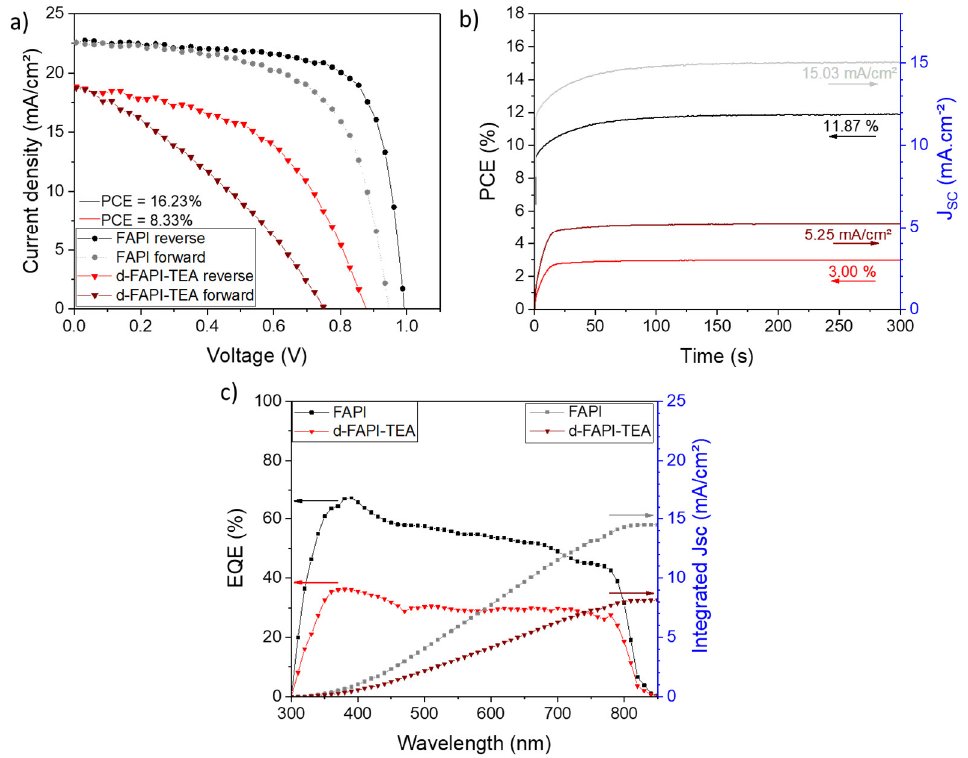
Figure 6. ( a ) J-V curves of best FAPI and d-FAPI-TEA devices. ( b ) Stabilized efficiency of best FAPI and d-FAPI-TEA devices (the applied V max are 0.79 V and 0.57 V, respectively). ( c ) EQE spectra (left) with integrated J SC (right) of best FAPI and d-FAPI-TEA devices. The arrows point out the Y-axis to read.